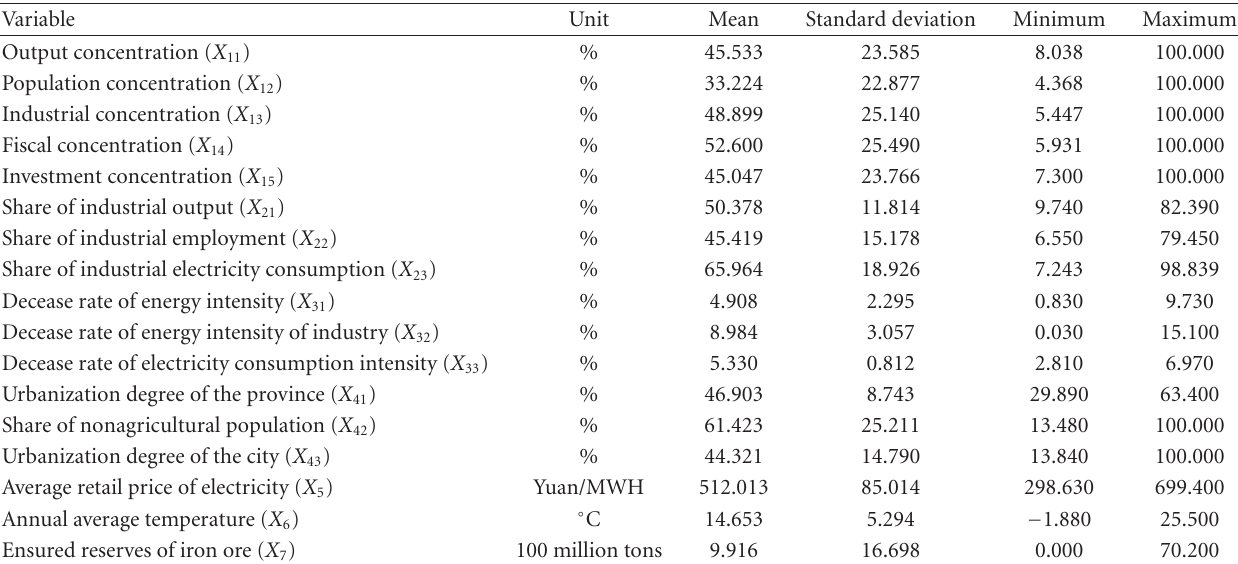
Table 3: Descriptive statistics and units of original